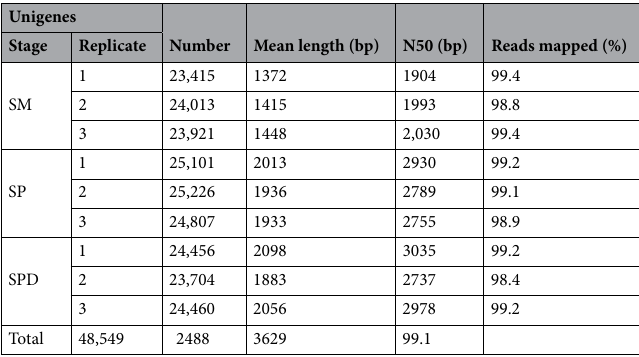
Table 1. The assembled results for S. latifolia transcriptome.